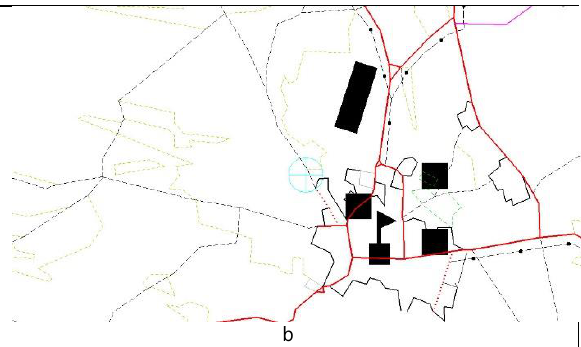
Figure 3. a: polygons before generalization, b: merged polygons after generalization